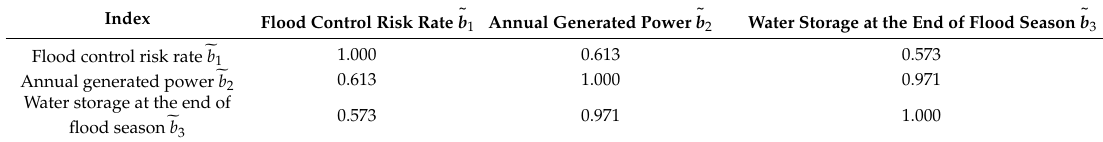
Table 6. Correlation coe ffi cient matrix of the standardized interval number decision